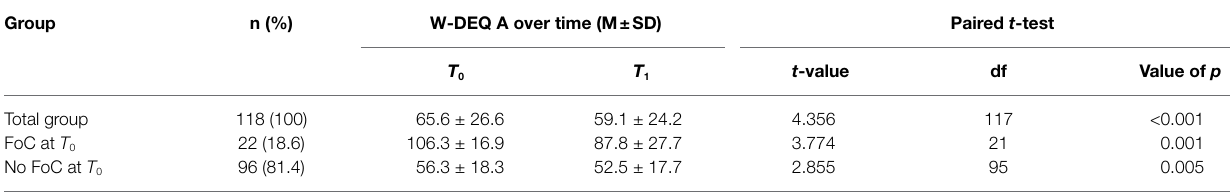
TABLE 3 | Changes in W-DEQ A scores in the longitudinal sample.